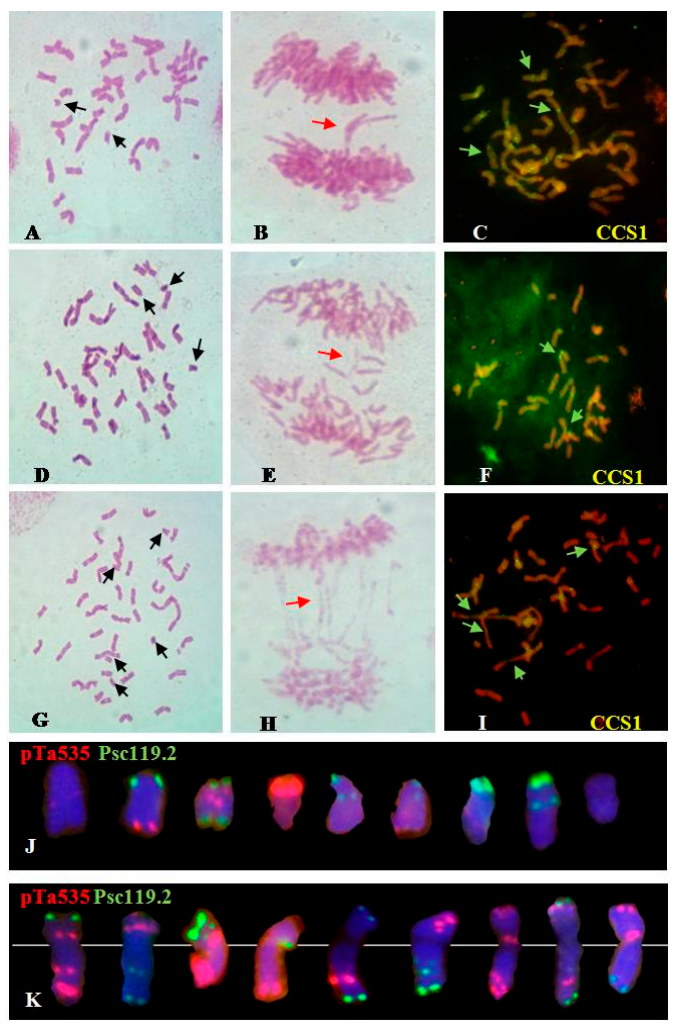
Figure 2. Summary of the irradiation-induced chromosomal aberrations in the M 0 generation. ( A – C ): Feulgen staining and fluorescence in situ hybridization (FISH) analyses of M 0 generation of 100 Gy group; ( D – F ): Feulgen staining and FISH analyses of M 0 generation of 200 Gy group; ( G – I ): Feulgen staining and FISH analyses of M 0 generation of 300 Gy group; ( J , K ): Fragments and translocations. Black arrows indicate fragments, red arrows indicate chromatin bridges, and green arrows indicate dicentrics. Oligo-CCS1 can be used as probe to investigate centromeric structure [15]. Chromosomes were counterstained with 4 ′ -6-diamidino-2-phenylindole (blue).